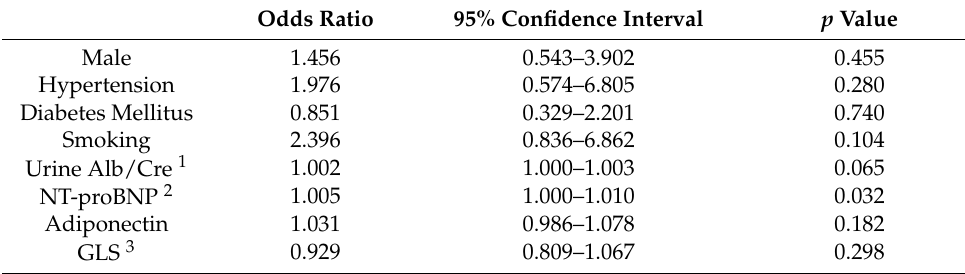
Table 3. Multiple logistic regression analysis for Stage B heart failure